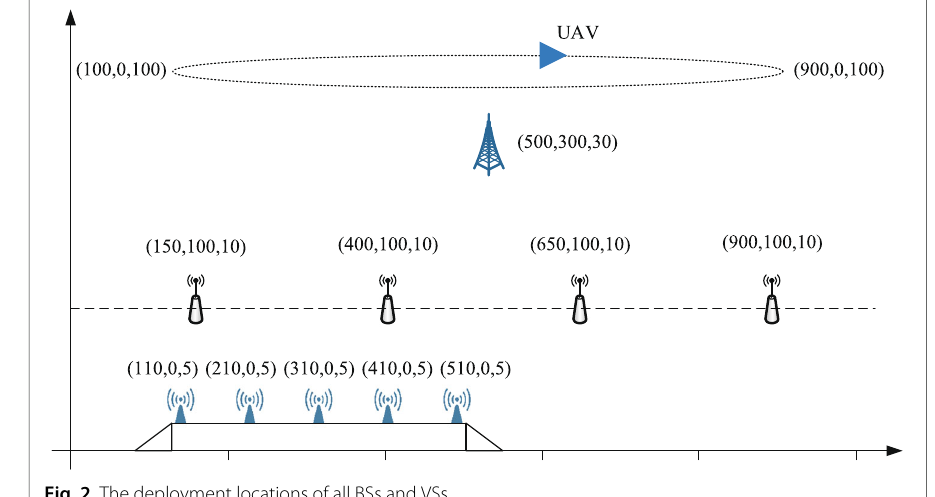
Fig. 2 The deployment locations of all BSs and